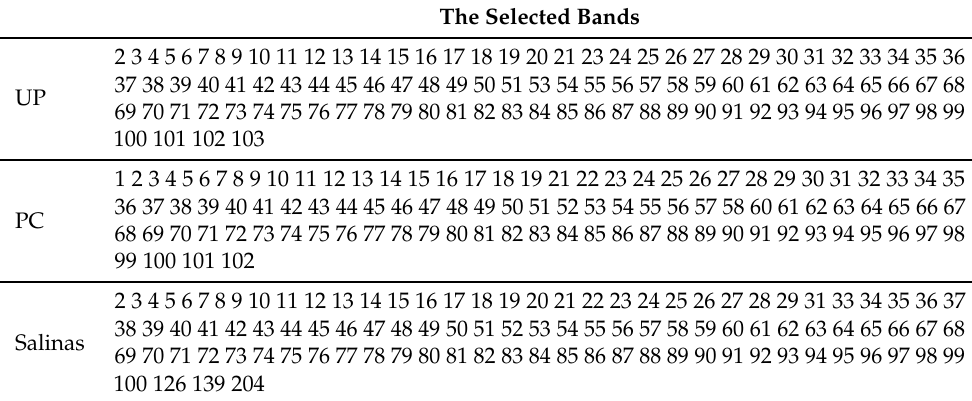
The selected bands on the target data sets via GRBS. University of Pavia (UP), Pavia Center (PC). The Selected